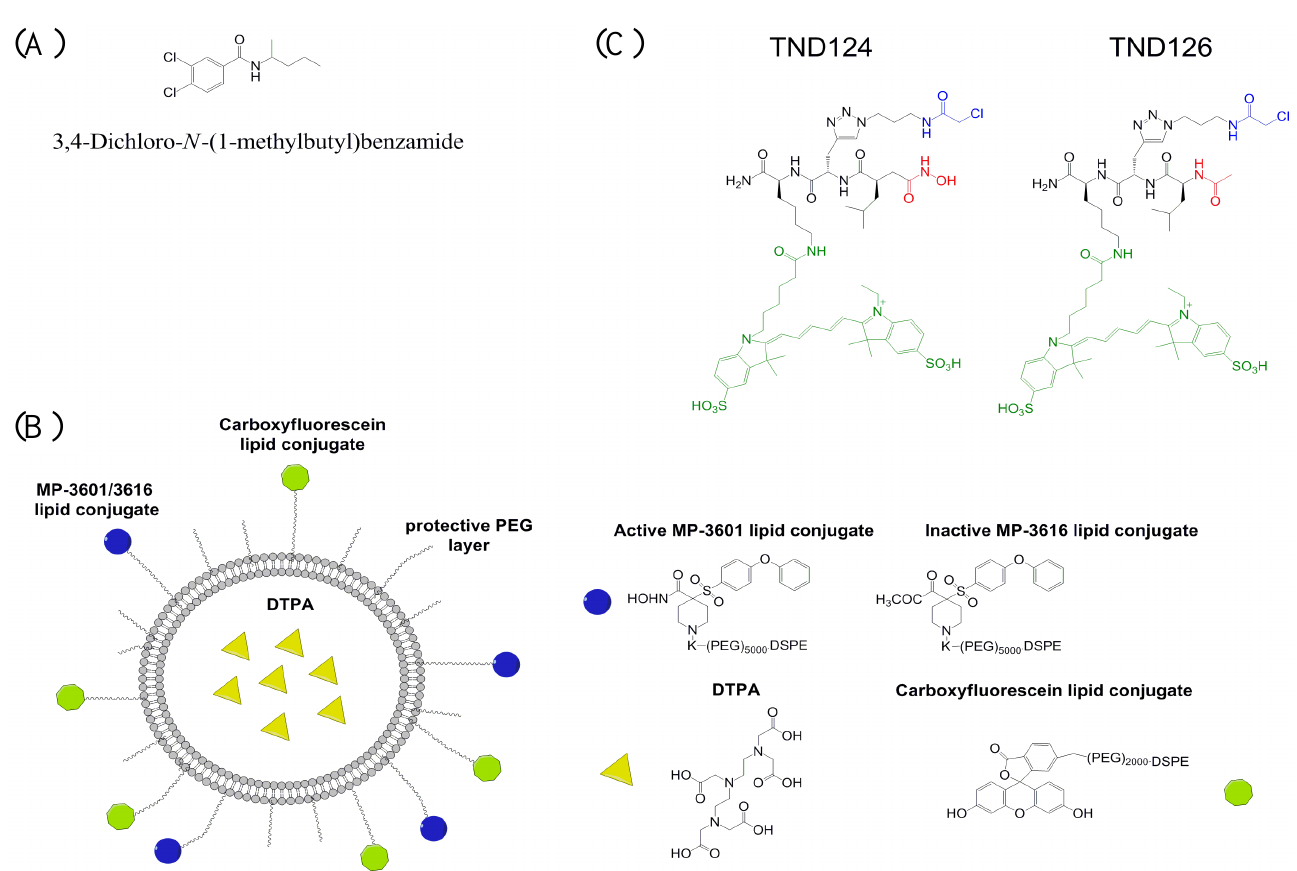
Figure 4. Structures of ( A ) MT1-MMP inhibitor NSC405020, 3,4-dichloro- N